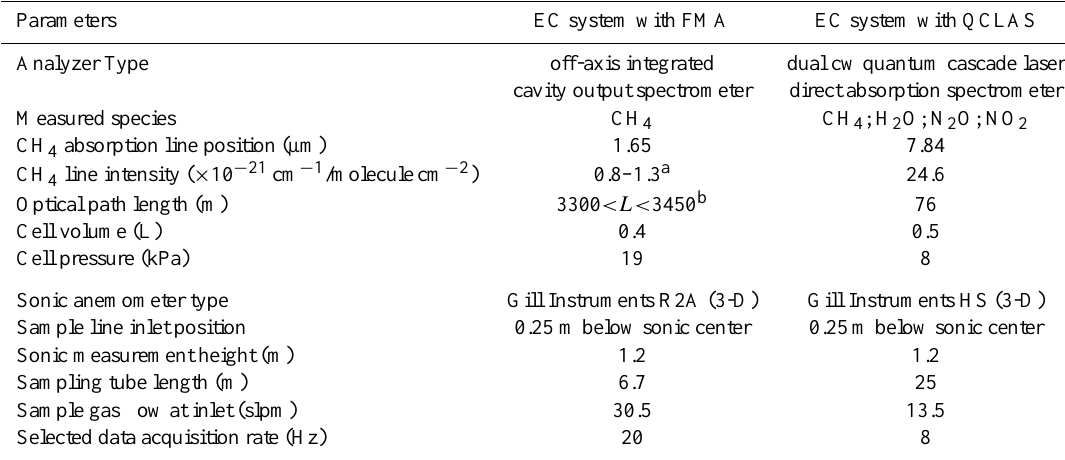
Table 1. Characteristics of the two EC flux systems and respective analyzers. Parameters EC system with FMA